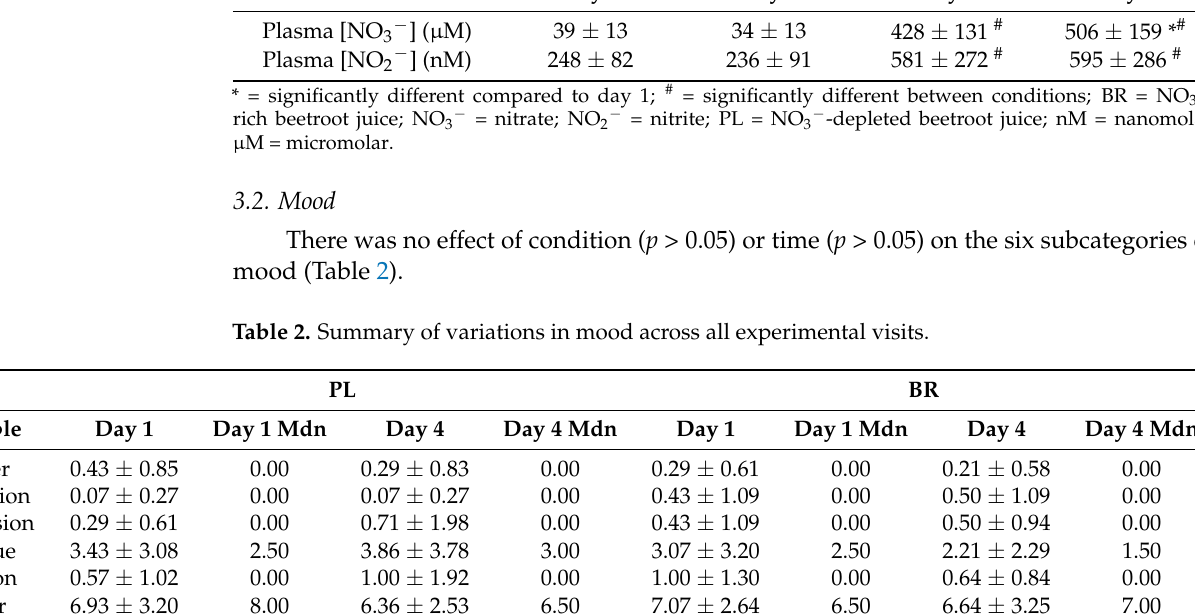
Table 1. Plasma nitrate and nitrite concentrations following 1 and 4 days of dietary nitrate ingestion. PL BR Variable Day 1 Day 4 Day 1